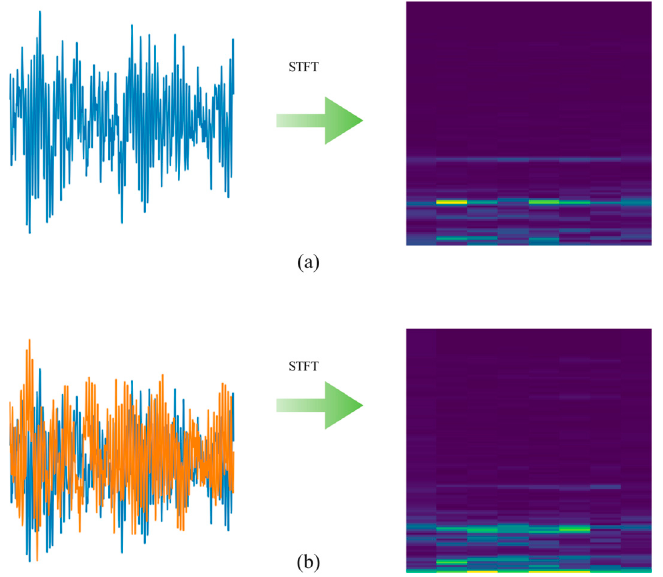
Figure 7. Short-time Fourier transform coding: ( a ) divided into vibration data of a single channel, ( b ) divided into vibration data of two channels.